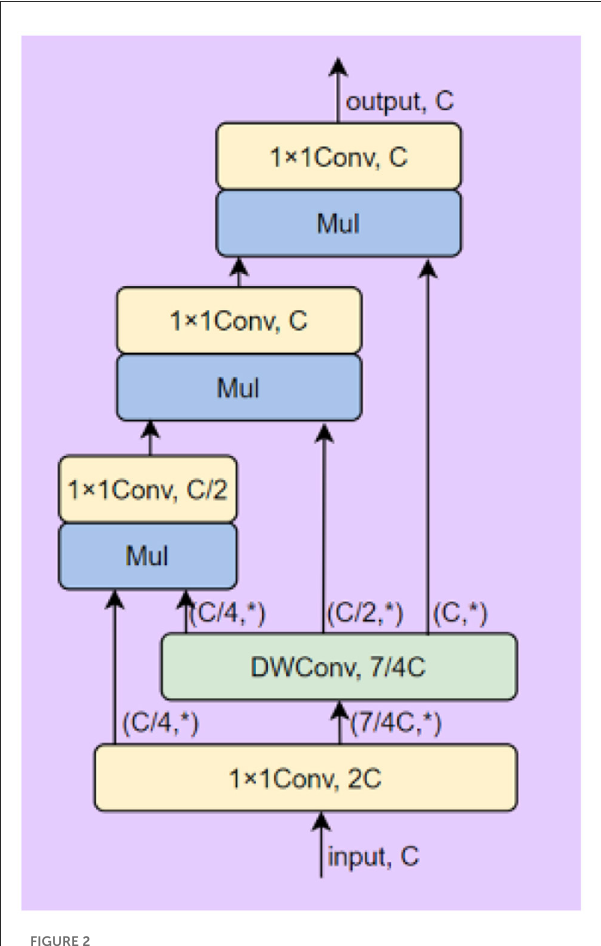
FIGURE2 The structure of the recursive gated convolution